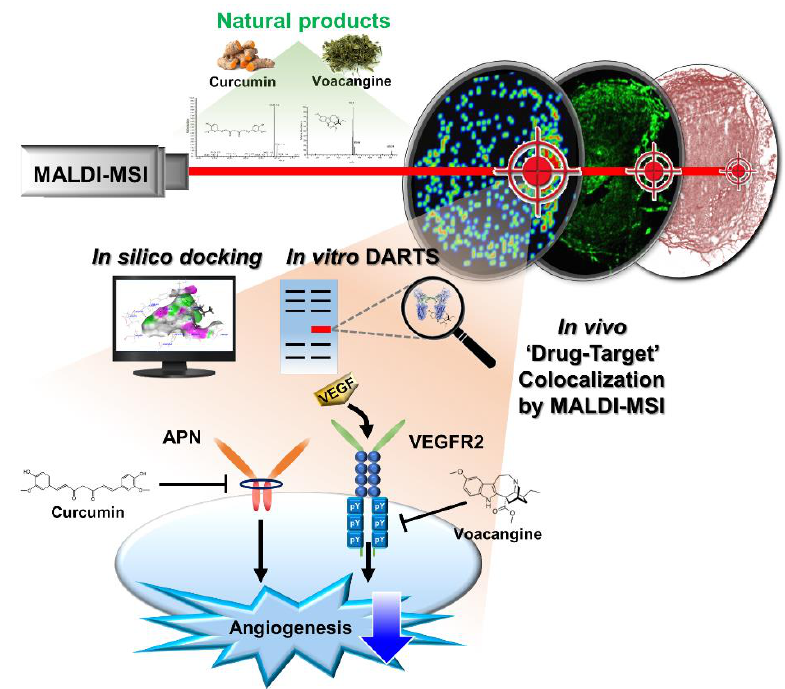
Figure 7. Summary of the study . The systematic approach using the combination of DARTS-MSI for in vitro and in vivo target identification and validation of natural products.